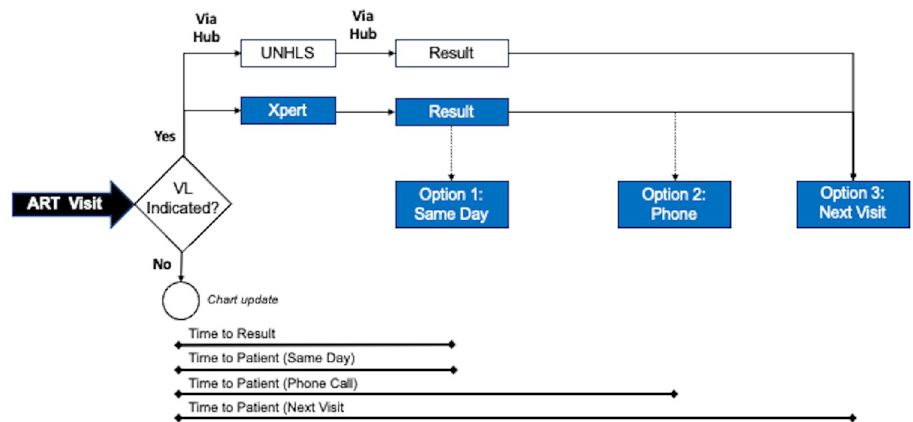
Fig 2. Flowchart illustrating parallel viral load testing and study outcomes in Phase